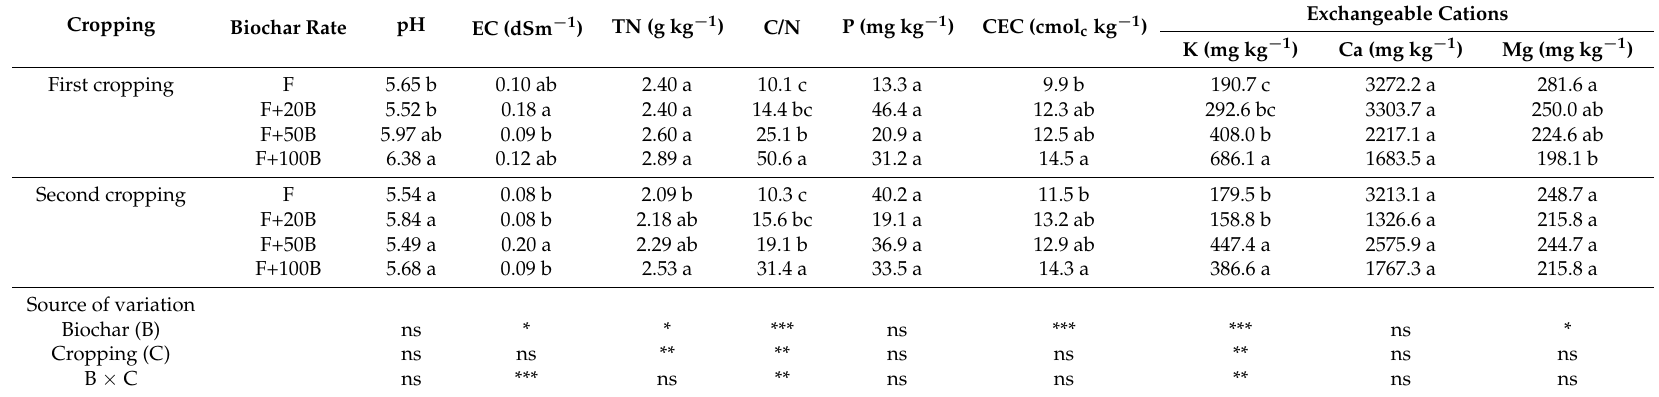
Table 4. The soil chemical properties of sesame under the different biochar treatments in different cropping after harvesting.